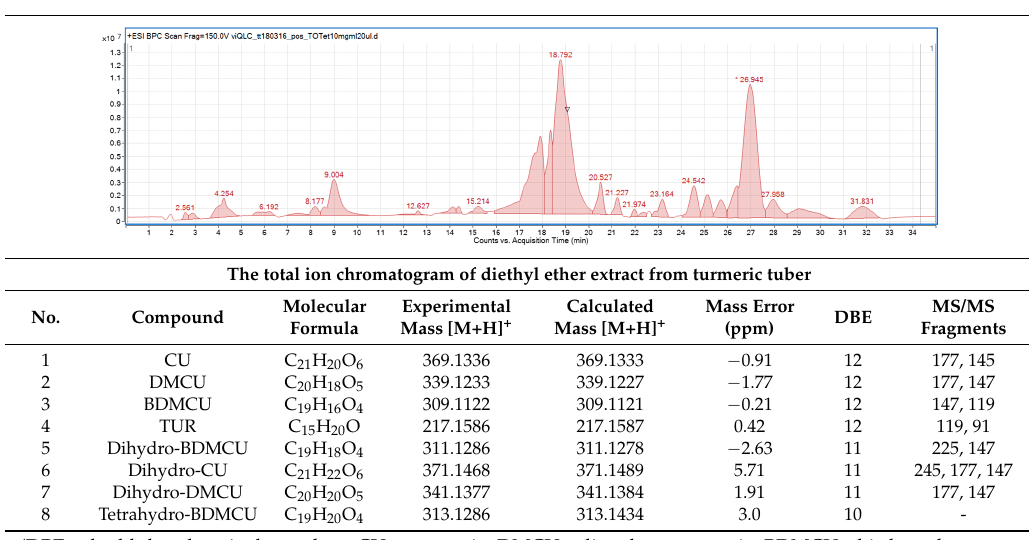
Table 1. LC-ESI-Q-TOF-MS accurate mass measurements of phenolics and terpenes identified in the MeOH and diethyl ether extracts of Curcuma longa tubers.